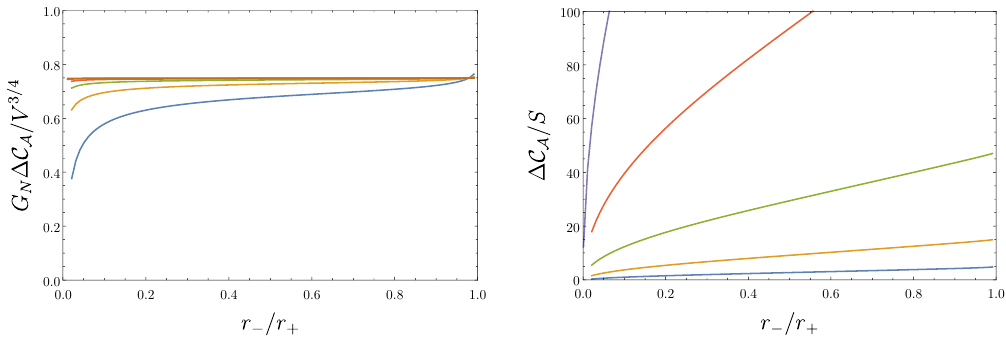
Figure 7. The complexity of formation is shown as a function of r − /r + normalized by a power of the thermodynamic volume (left) and the entropy (right). The curves, in order from bottom to top, correspond to r + /‘ = 10 3 , 10 4 , 10 5 , 10 6 , 10 7 and 10 8